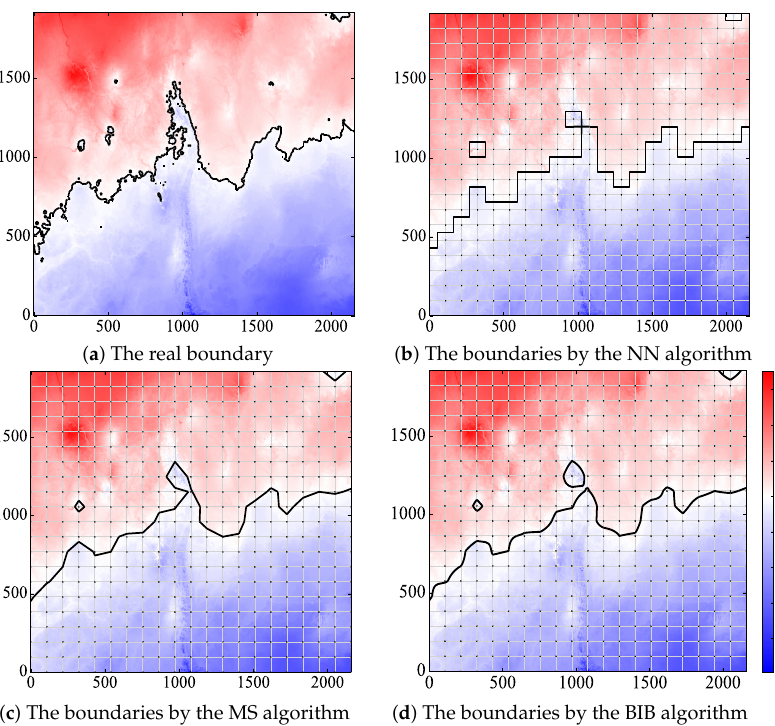
Figure 15. The real boundary and the boundaries generated by the three mentioned algorithms in ROI when n = 20 in the real temperature data